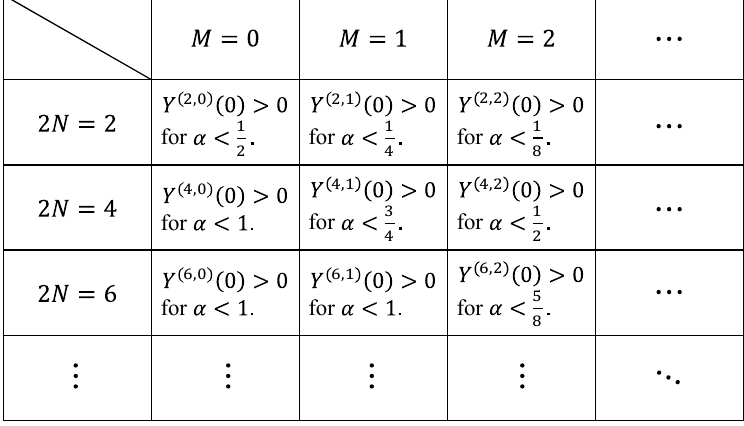
Figure 1 . This (cid:12)gure shows which inequalities must be satis(cid:12)ed for generic (cid:11) > 0. For (cid:11) > 0 case, all the bounds could be violated when t > 0. When t = 0, some of the bounds must still be satis(cid:12)ed for 0 < (cid:11) < 1 case: for (cid:12)xed M and (cid:11) with 0 < (cid:11) < 1, inequalities with 2 N > 1 + (2 + 2 M ) (cid:11) must be satis(cid:12)ed. For (cid:12)xed N and (cid:11) with 0 < (cid:11) < 1, inequalities with M (cid:21) (2 (cid:11) ) (cid:0) 1 (2 N (cid:0) 1) (cid:0) 1